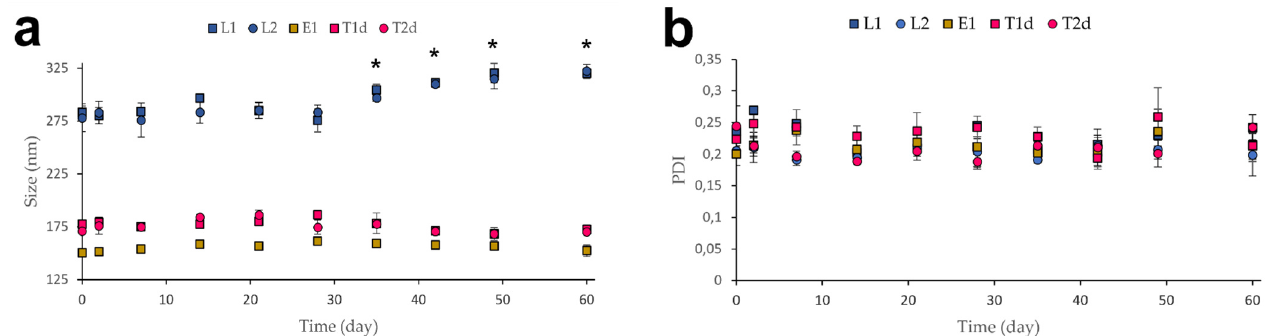
Figure 5. ( a ) Vesicle size over 2 months of storage (4 ◦ C); ( b ) PDI over 2 months of storage (4 ◦ C). All results are expressed as mean ± SD ( n = 3). * means statistically significant differences when compared to the initial values ( p < 0.05) using one-way ANOVA followed by Tukey’s multiple comparison test.